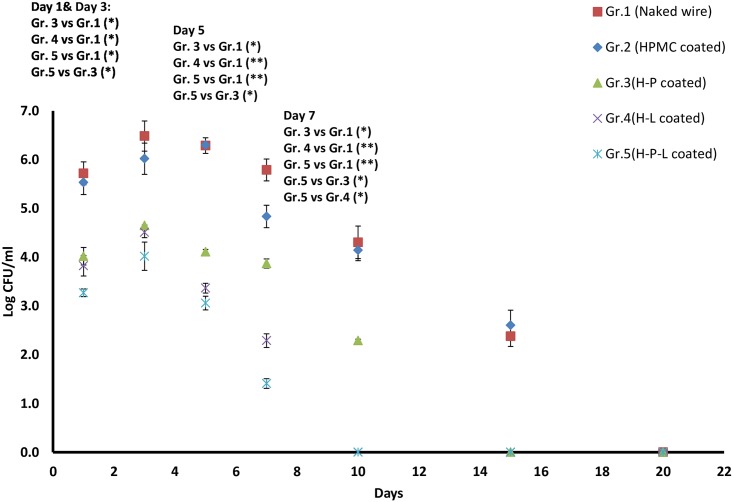
Bacterial load (Log CFU/ml) on implanted K-wire in mice on different days post infection with S. aureus 43300.Data points represent mean ± S.D of three independent values. p values among groups have been determined where (*) represent p<0.05 and (**) represent p<0.01.